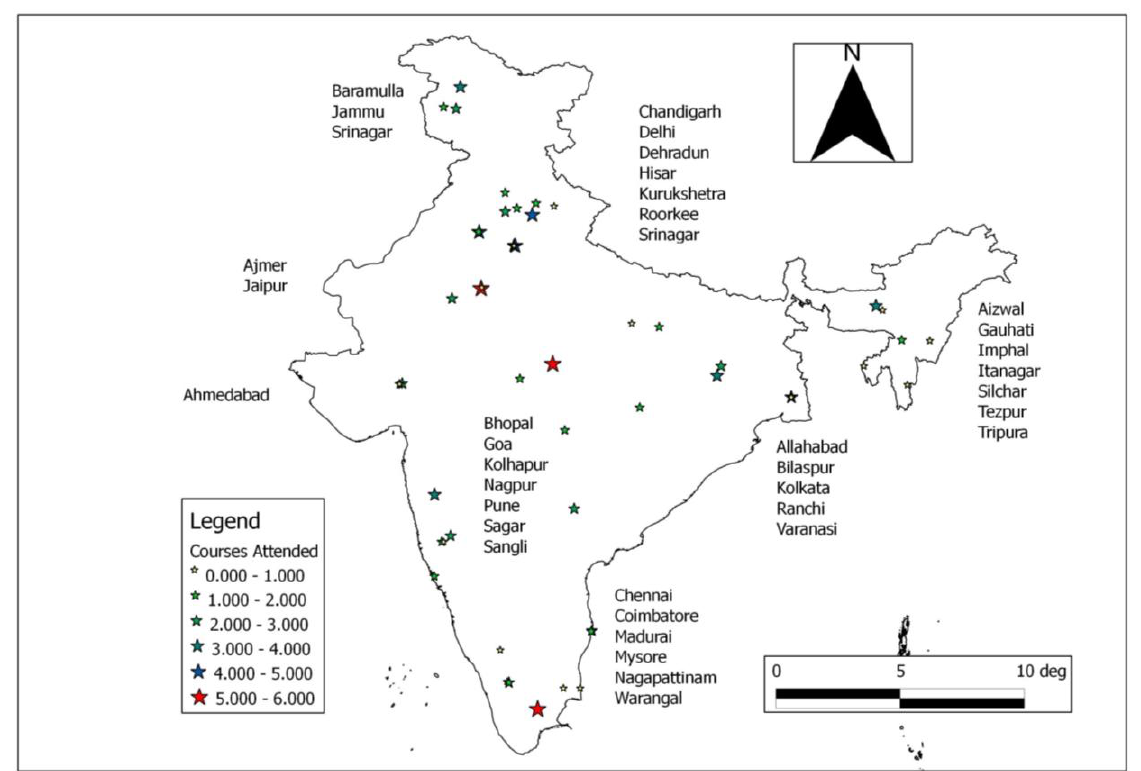
Table 7. EDUSAT Course Participation Summary